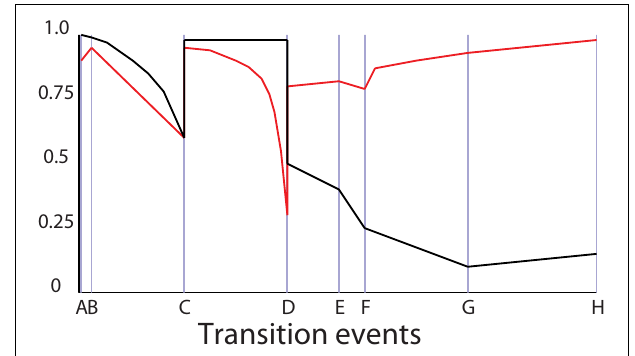
FIGURE 4 | Normalized indexes of execution speed (black) and fidelity (red) the against configuration changes through time associated with Figure